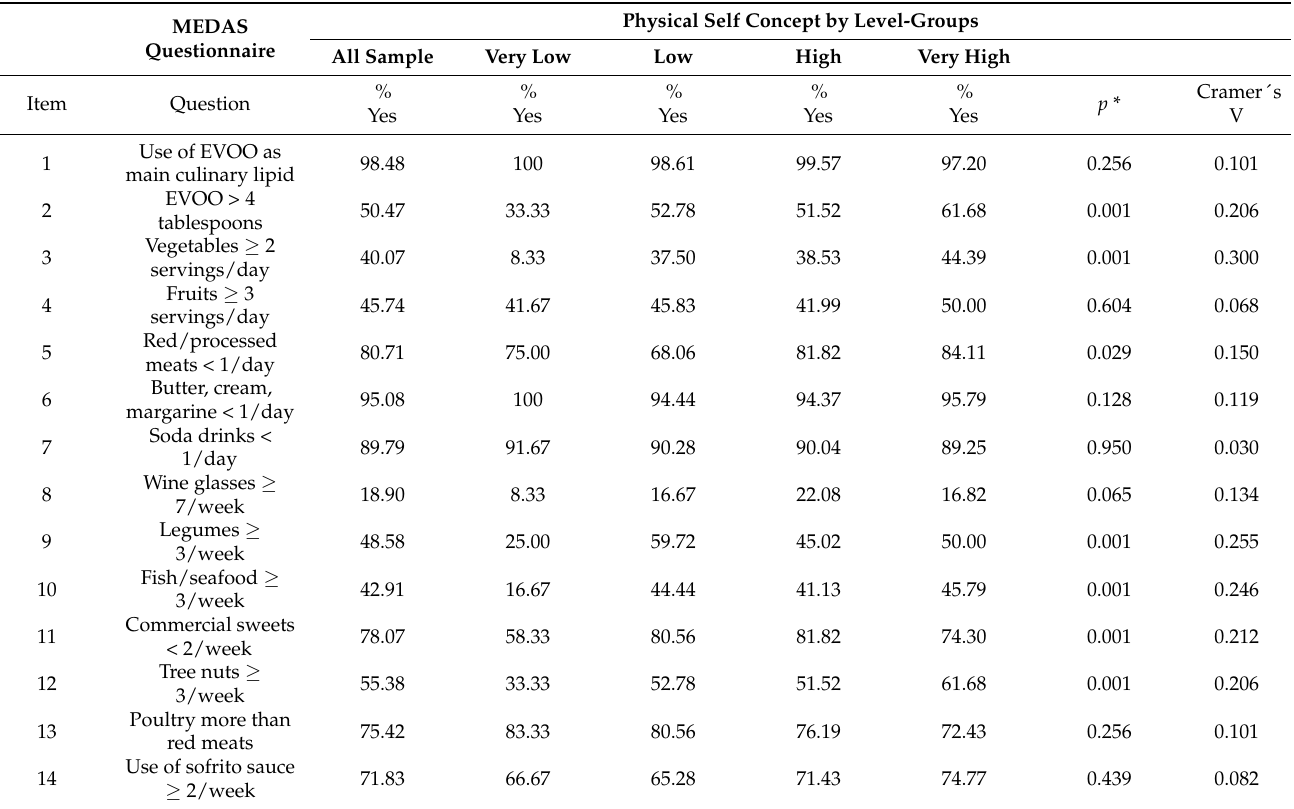
Table 4. Association between items of MEDAS and level-groups of physical